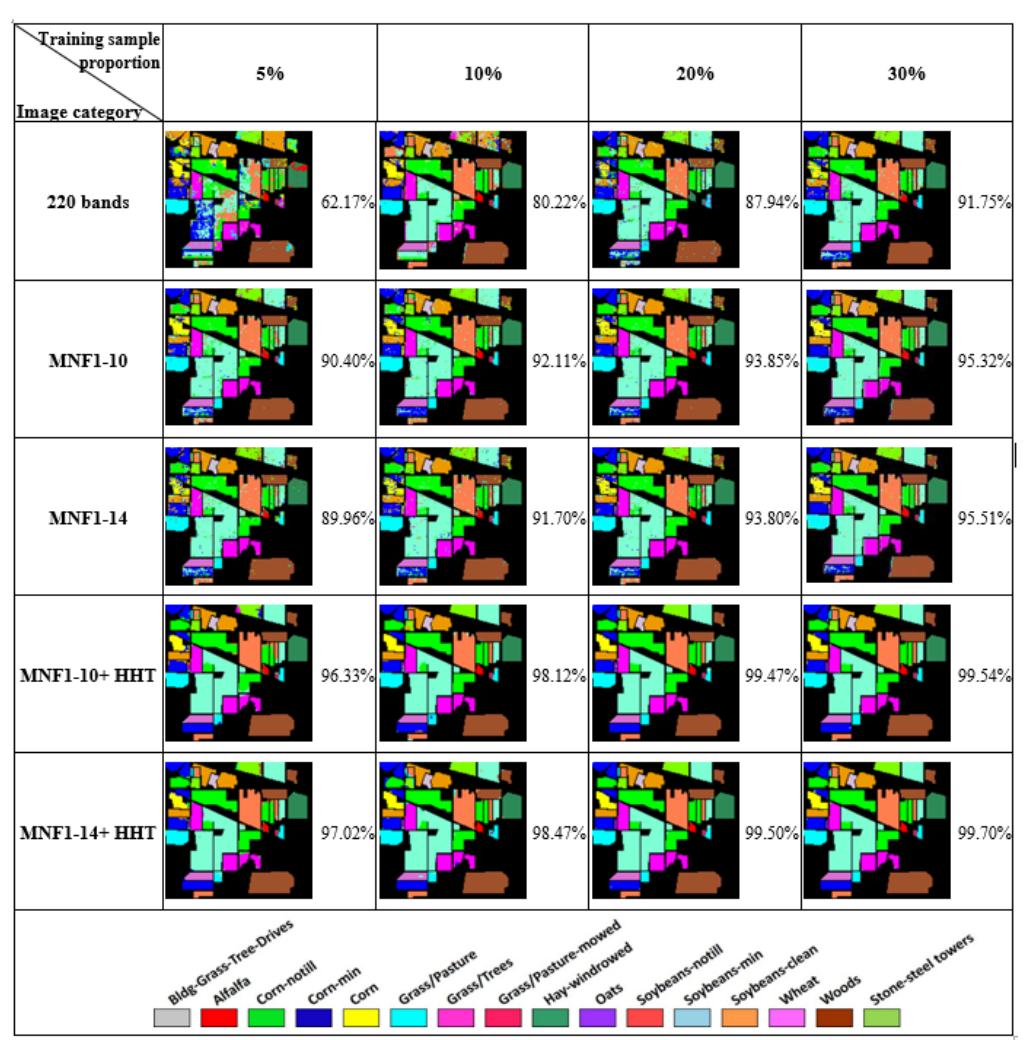
Figure 3. Classification results with overall accuracy values for IP dataset original 220 band images, MNF-transformed images, and MNF+HHT-transformed images with four training sample proportions.